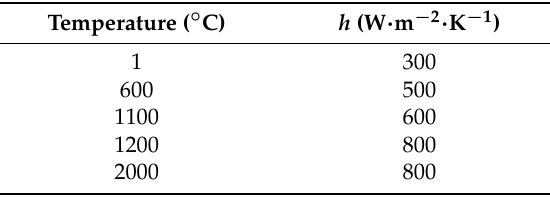
Table A3. HTC values used in the numerical simulation.